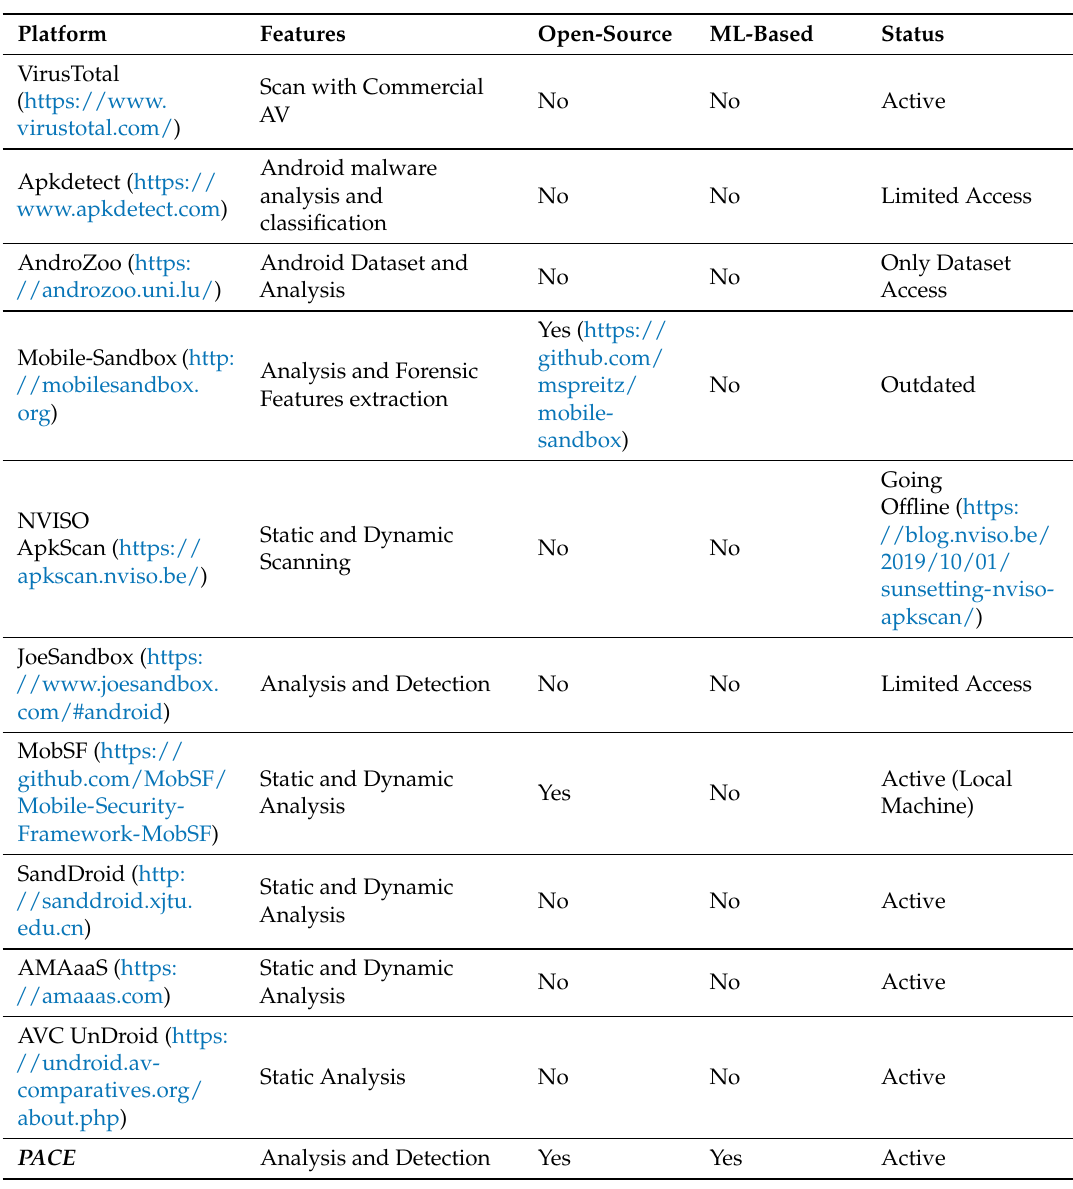
Table 1. Online Platform Related to Android